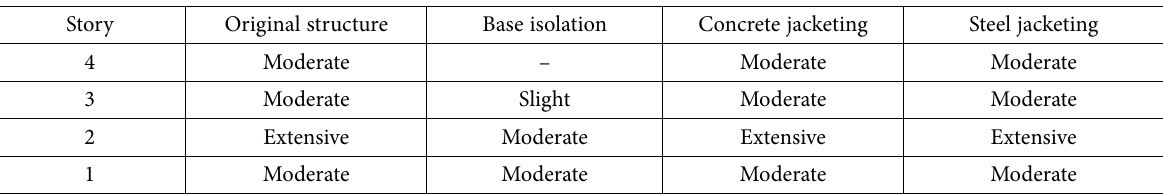
Table 2. Structural damage levels